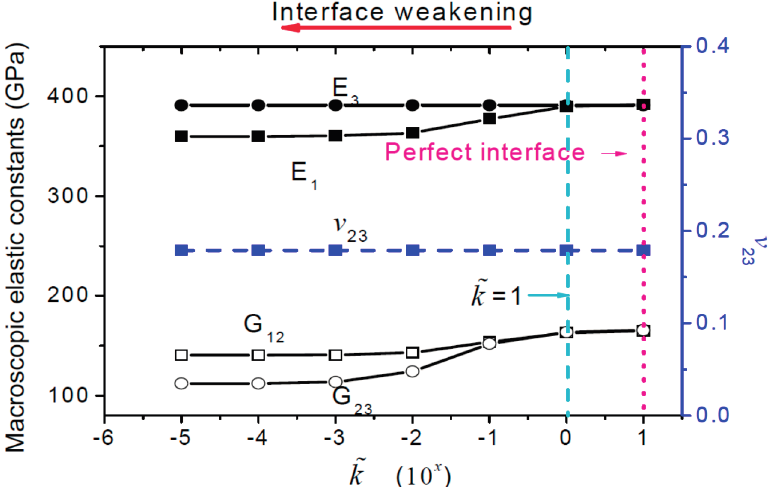
Figure 1. Influence of interface stiffness on the effective elastic constants (the arrows in red and in lightblue represent prefect interface and (cid:1863)(cid:3560) = 1, respectively).